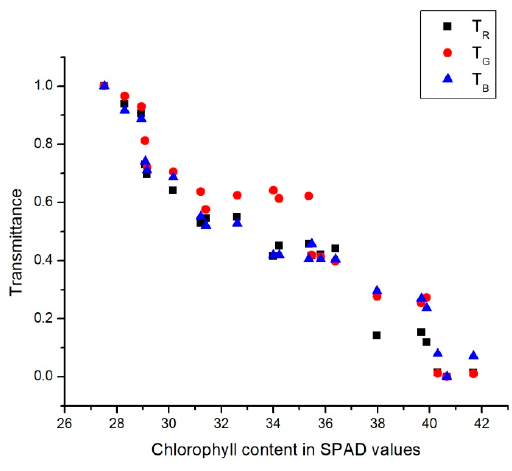
Figure 5. Reflectance according to the chlorophyll content in Soil Plant Analysis Development (SPAD) values.